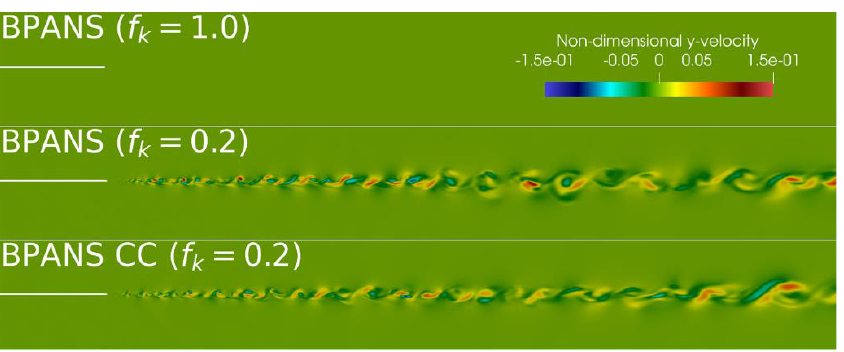
Figure 2. Stream velocity similarity profiles with comparison to experimental data [21].